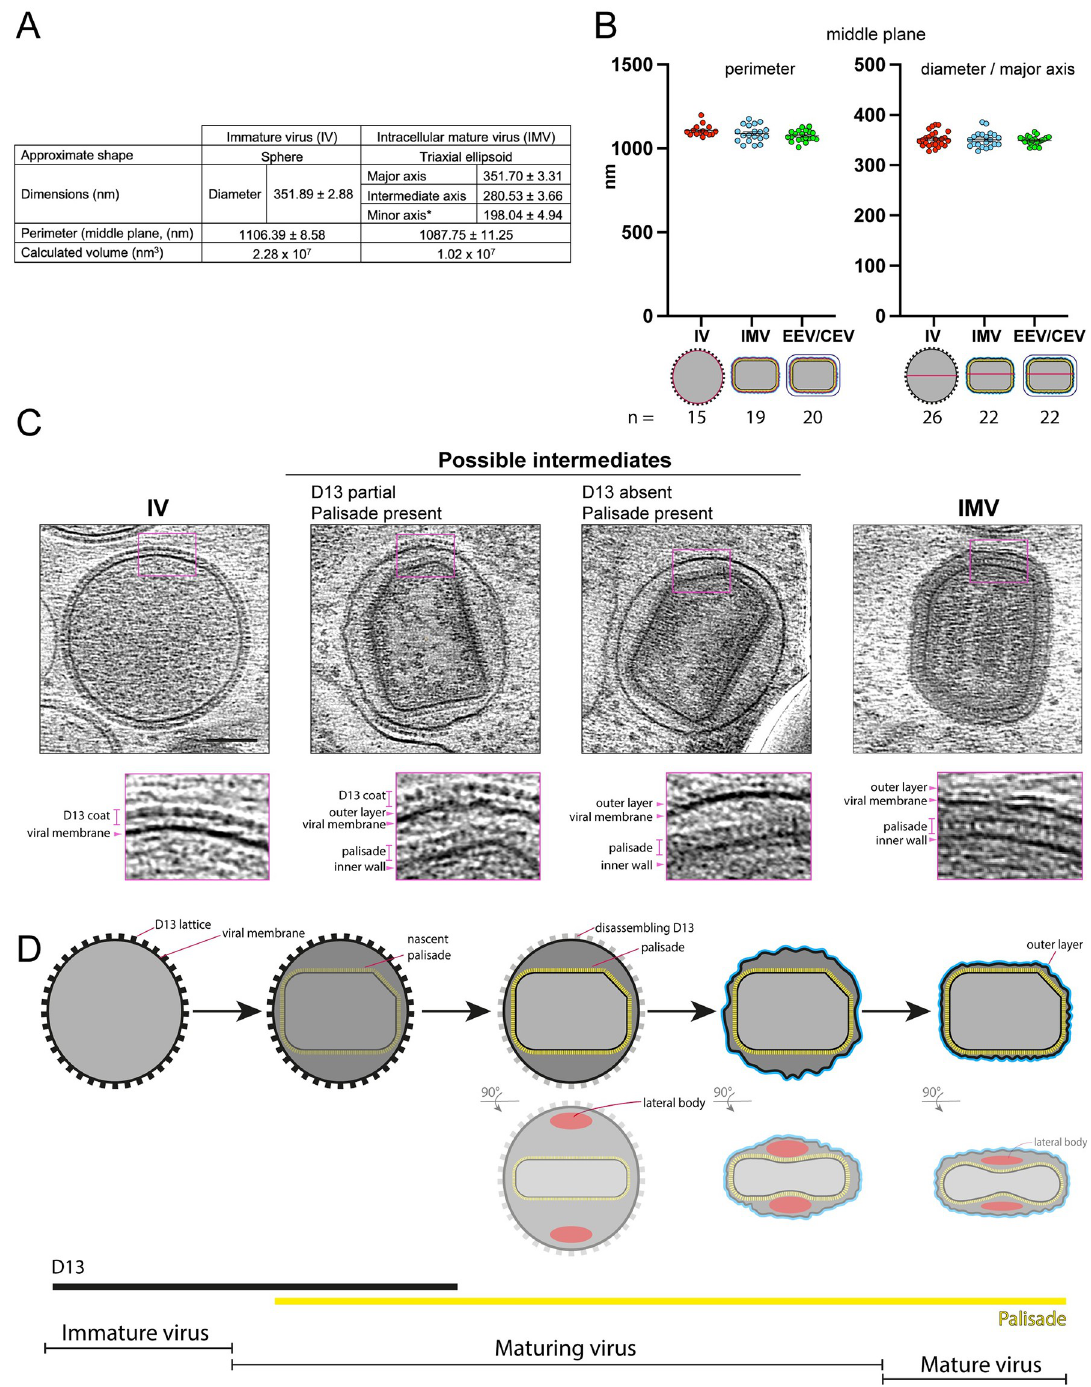
Fig 9. Maturation of vaccinia virus: From IV to IMV. ( A ) Middle view dimensions of IV (diameter, n = 26; perimeter, n = 15) and IMV (major axis, n = 22; intermediate axis, n = 19; minor axis, n = 10; perimeter, n = 19) tomograms. � Indicates that the IMV minor axis was calculated from the side views of 3 IMV and 7 IMV inside EEV (see Methods). For volume calculation, IV and IMV were assumed to be spheres and triaxial ellipsoids, respectively. S3 Table shows the individual numerical data. ( B ) Plots showing the individual values for perimeter and diameter/major axis (magenta lines in schematics below graph) of the IV, IMV, and EEV/CEV. IV and IMV measurements were used to calculate the averages shown in (A). The averages of the EEV inner-most membrane perimeter and major axis are 1,074.46 nm ± 7.09 nm and 348.91 ± 1.87 nm, respectively. ( C ) IV and IMV along with possible intermediates together with magnified regions (2.5 times) highlighting the different layers of each particle. Scale bar = 100 nm. ( D )